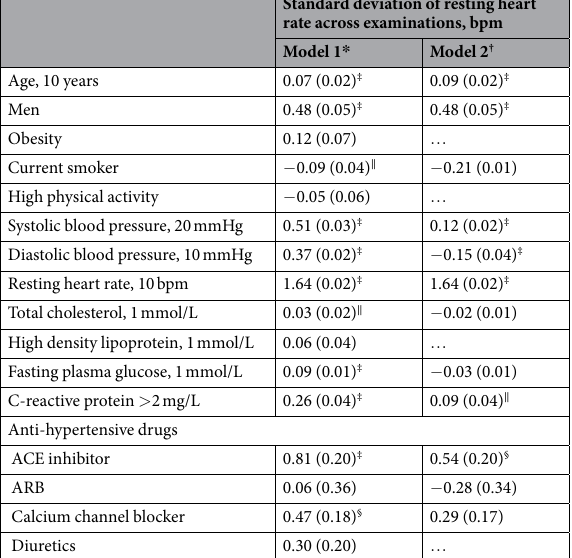
trendQuartile 1 ( < 3.6)